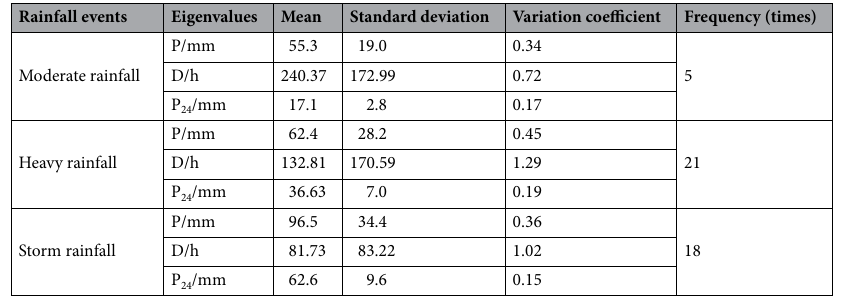
Table 2. Statistical features of different rainfall events. P, D, P 24 represents rainfall, rainfall duration and the maximum 24-h rainfall